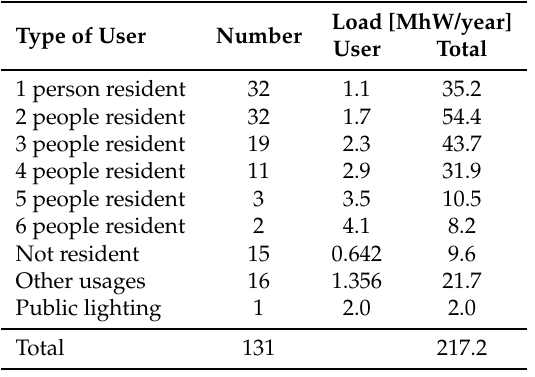
Table 1. Number and consumption of users in the energy community grouped by